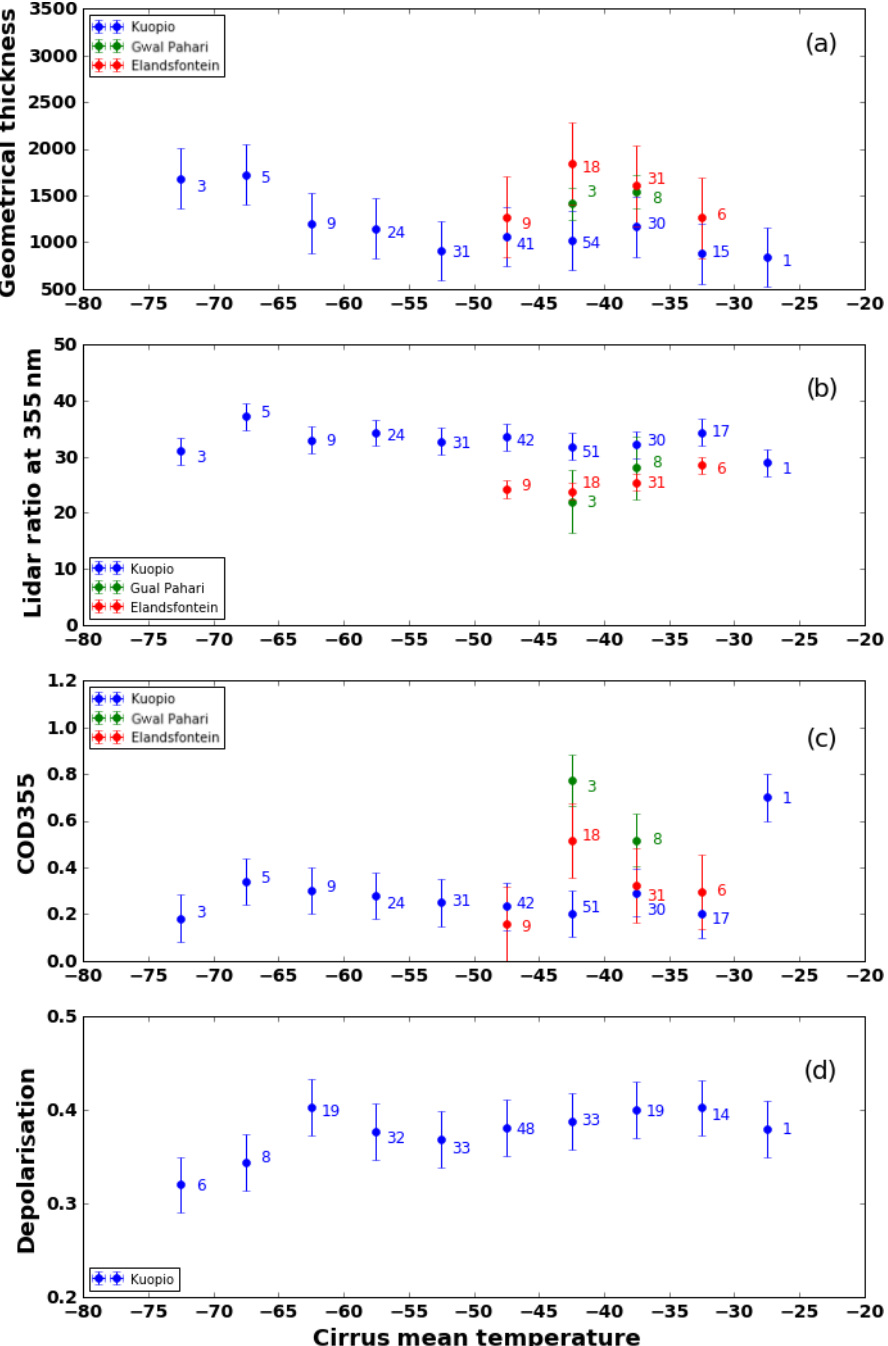
Figure 8. Dependencies of cirrus geometrical thickness (a) , lidar ratio at 355nm (b) , optical depth at 355nm (c) and particle depolarisation values (d) on 5 ◦ C intervals of mid-cirrus temperature. Numbers labelled indicate the number of cases per temperature bin.